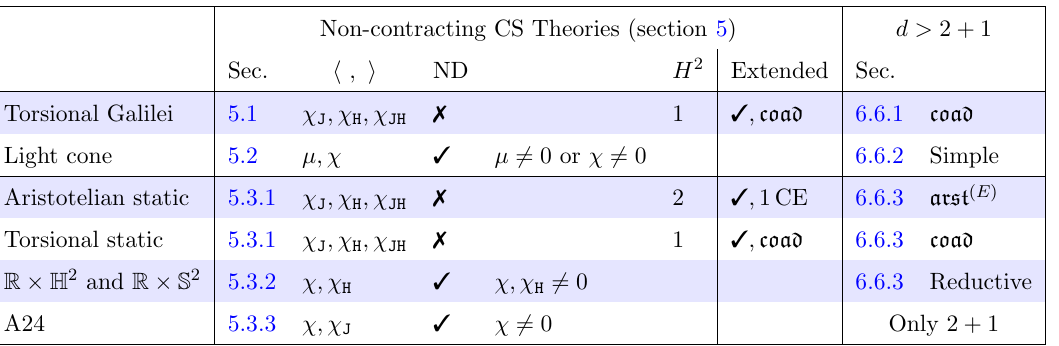
Table 11 . Non-contracting Chern-Simons